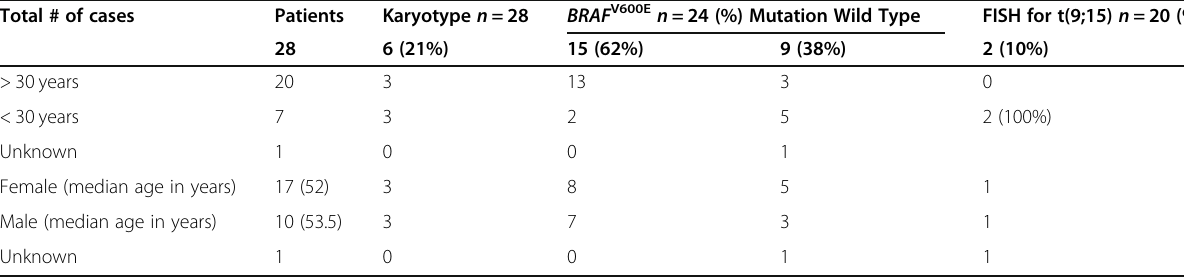
Table 2 Summary of cytogenetic and molecular findings Total # of